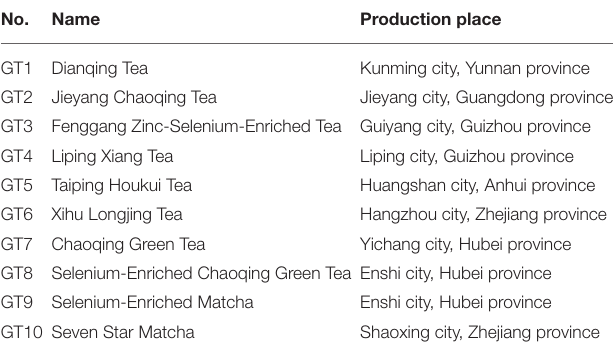
TABLE 1 | The details of 10 selected green teas from